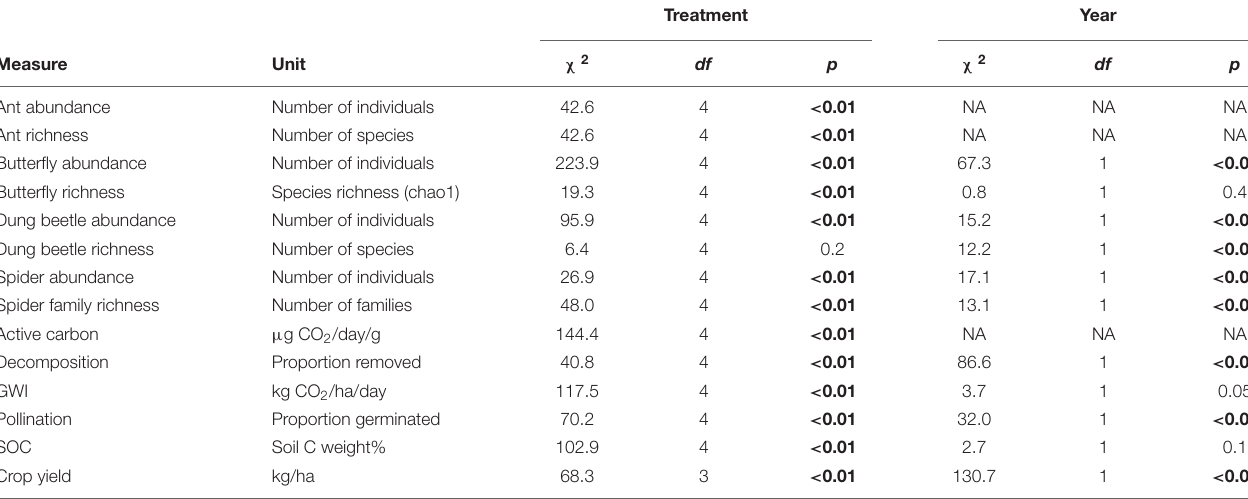
TABLE 1 | Effects of crop management treatments on measures of biodiversity and ecosystem services